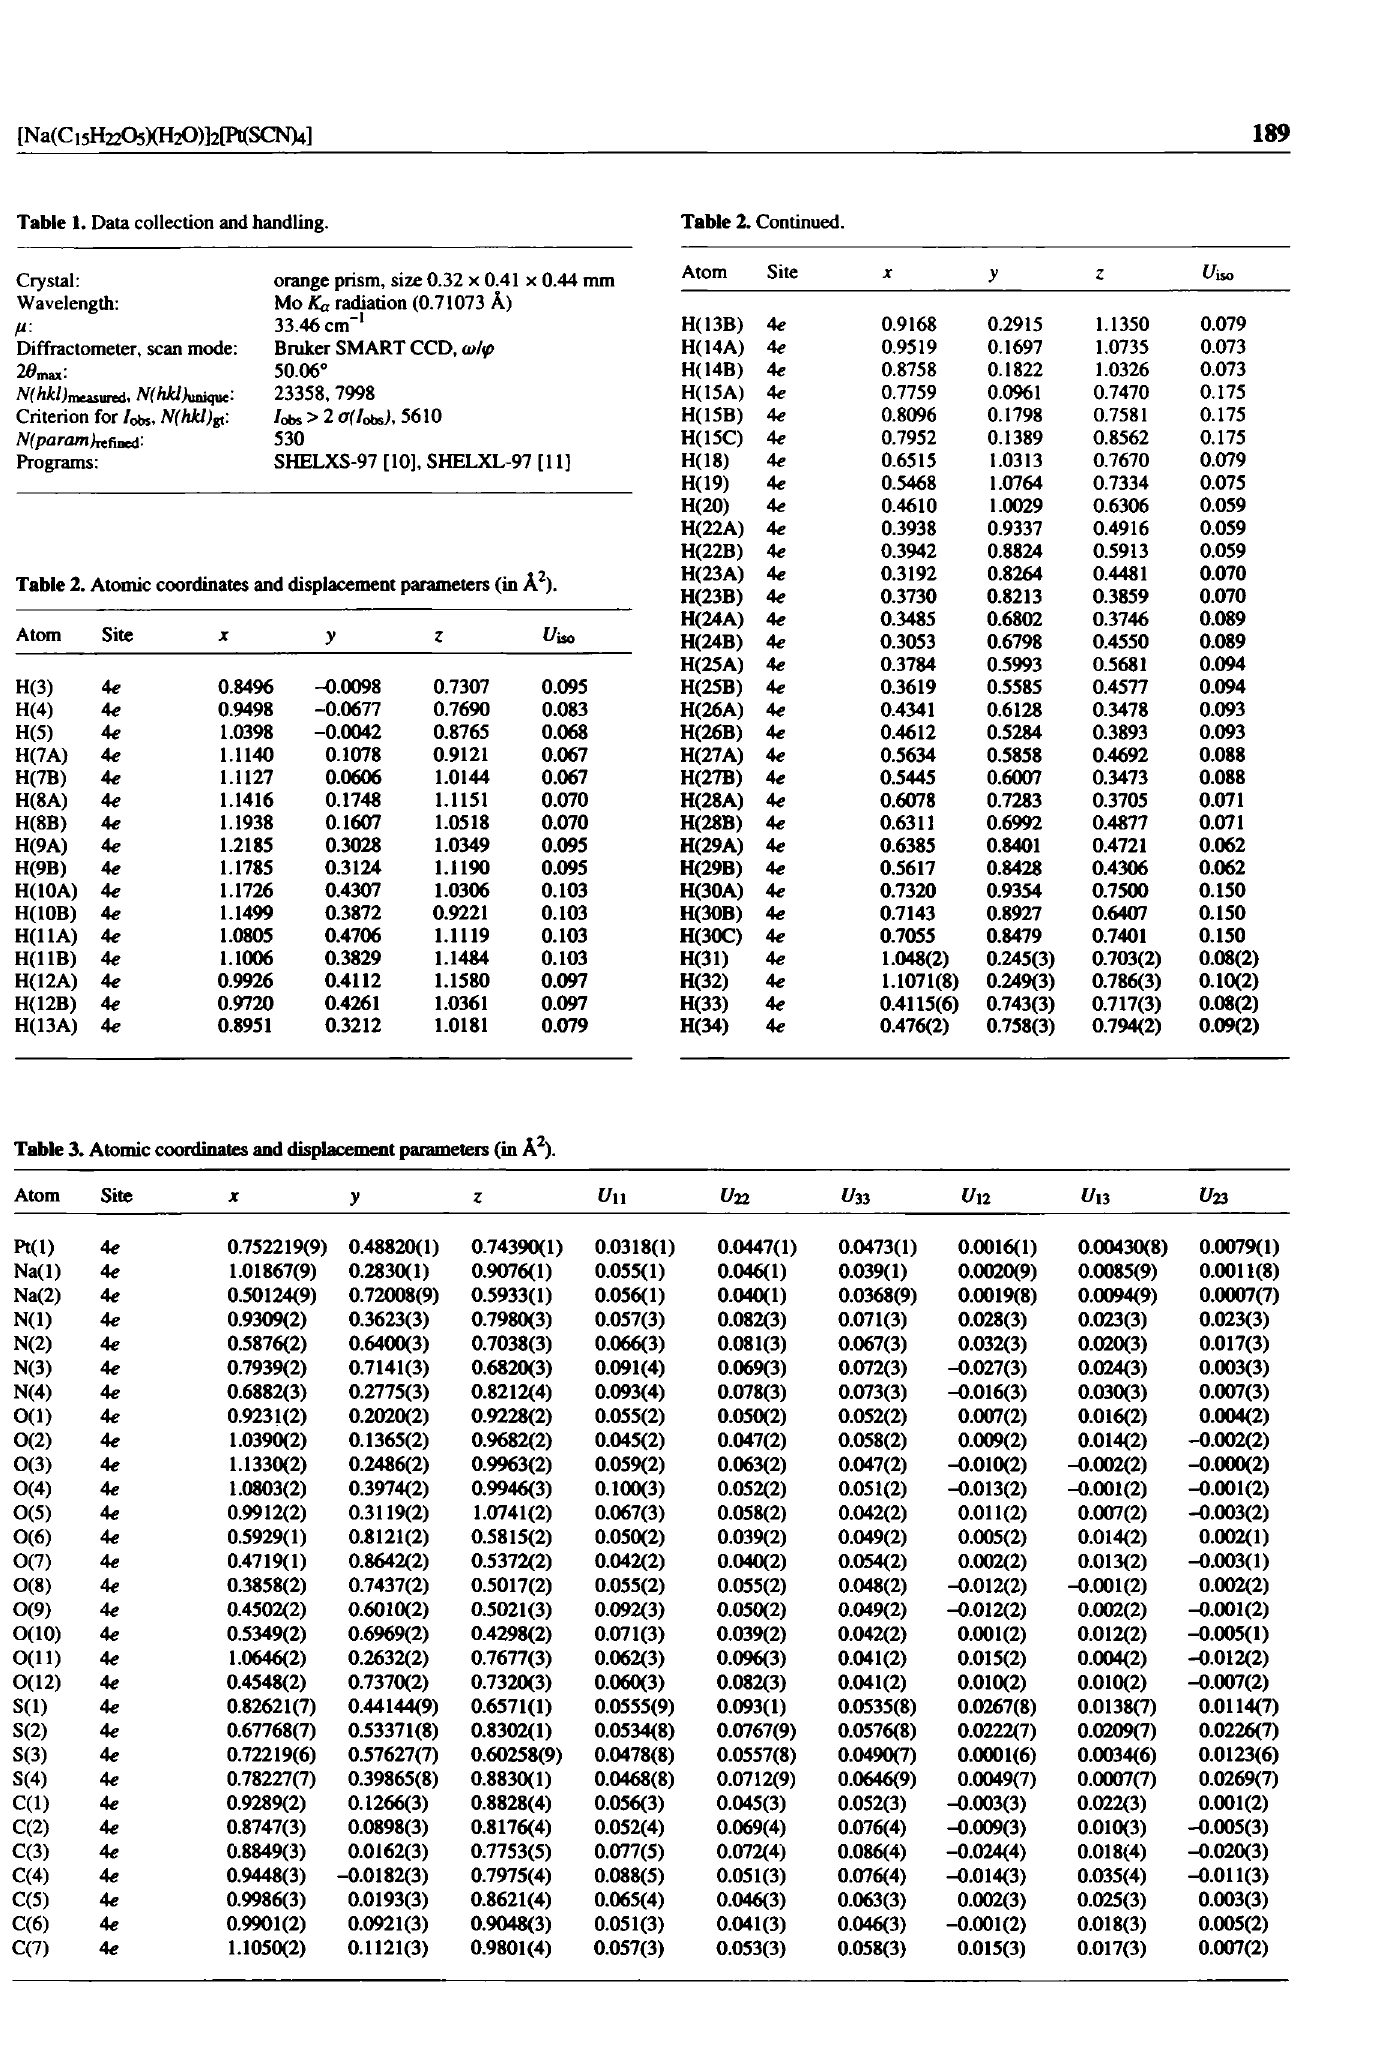
Table 2. Atomic coordinates and displacement parameters (in A 2 ).